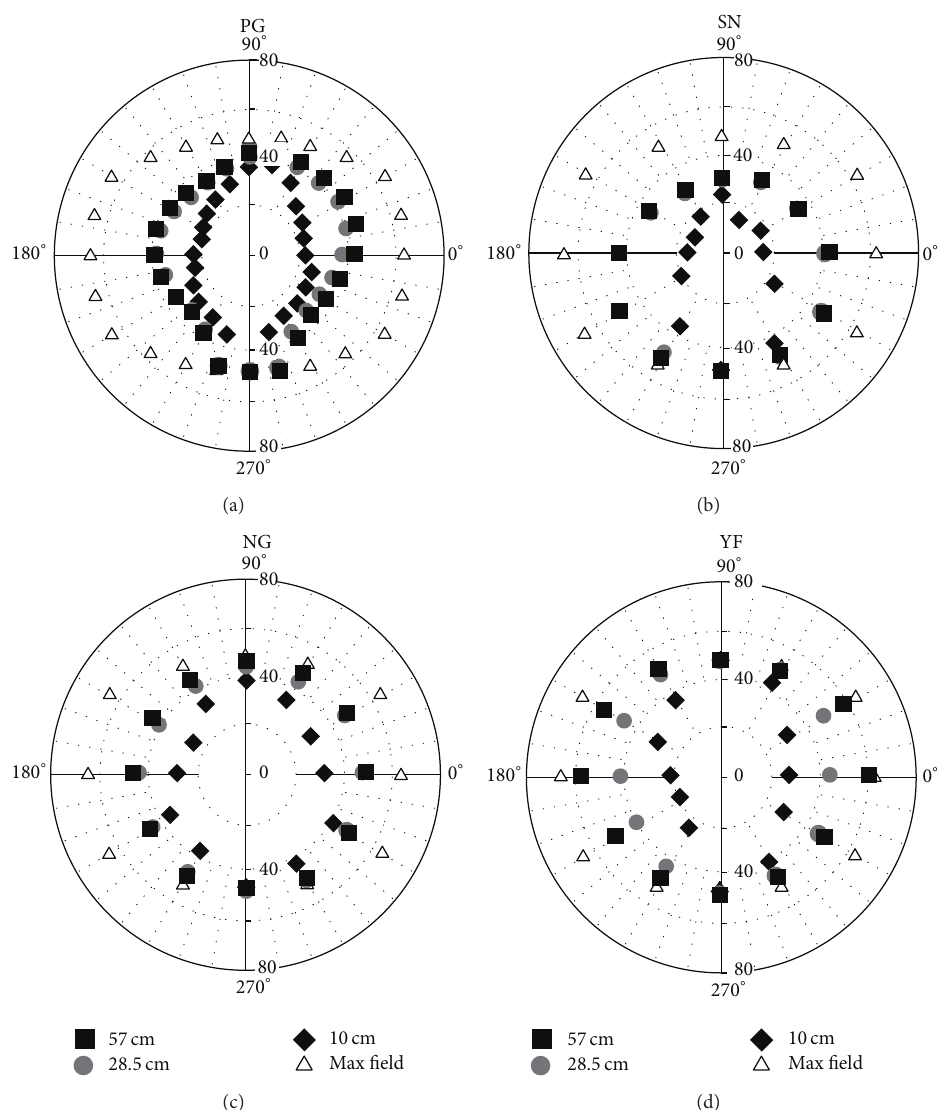
Figure 8: Individual polar plots of mean settings for “single to double” and “double to single” adjustments along each radius for three convergence distances. Closed symbols represent each simulated convergence distance. “Max field” refers to the extent of the stimulus display.